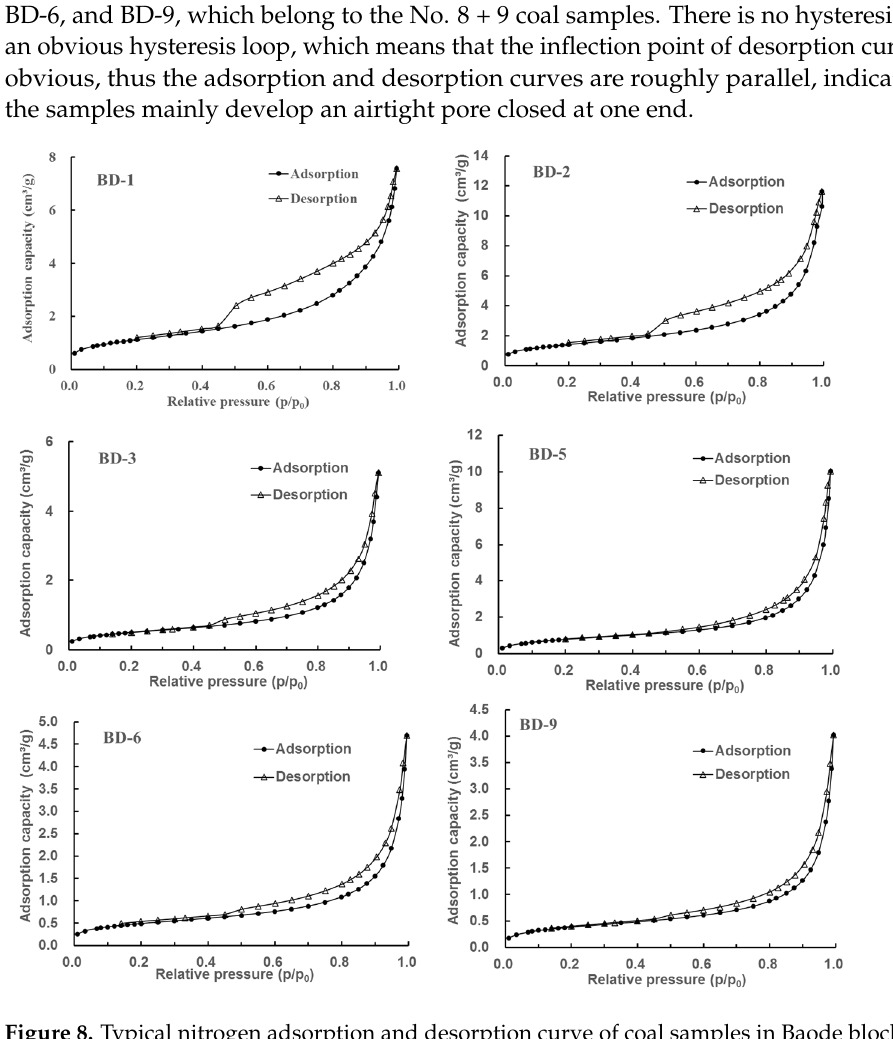
Figure 9. Relationship between pore diameter, SSA, and pore volume of typical coal samples in Baode block.